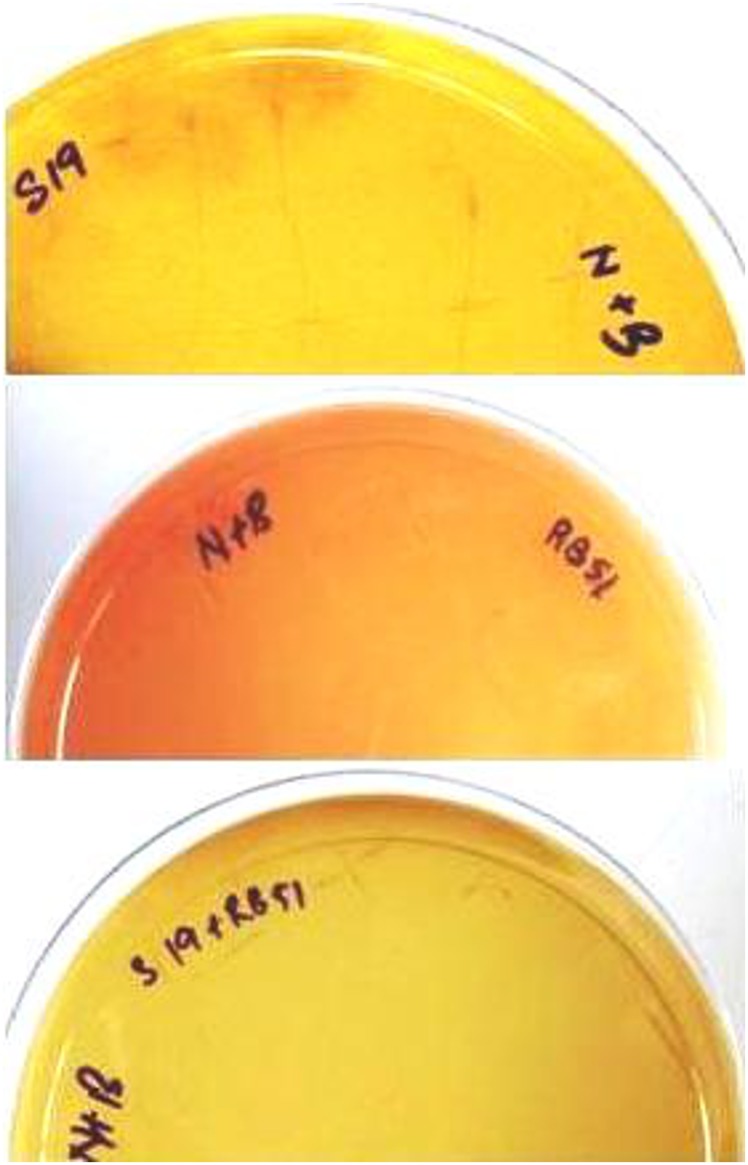
Absence of lysis on S19 lawn with lysates (top: S19, middle: RB51 and bottom: Cocktail lysate) indicating that they are phage—Free.